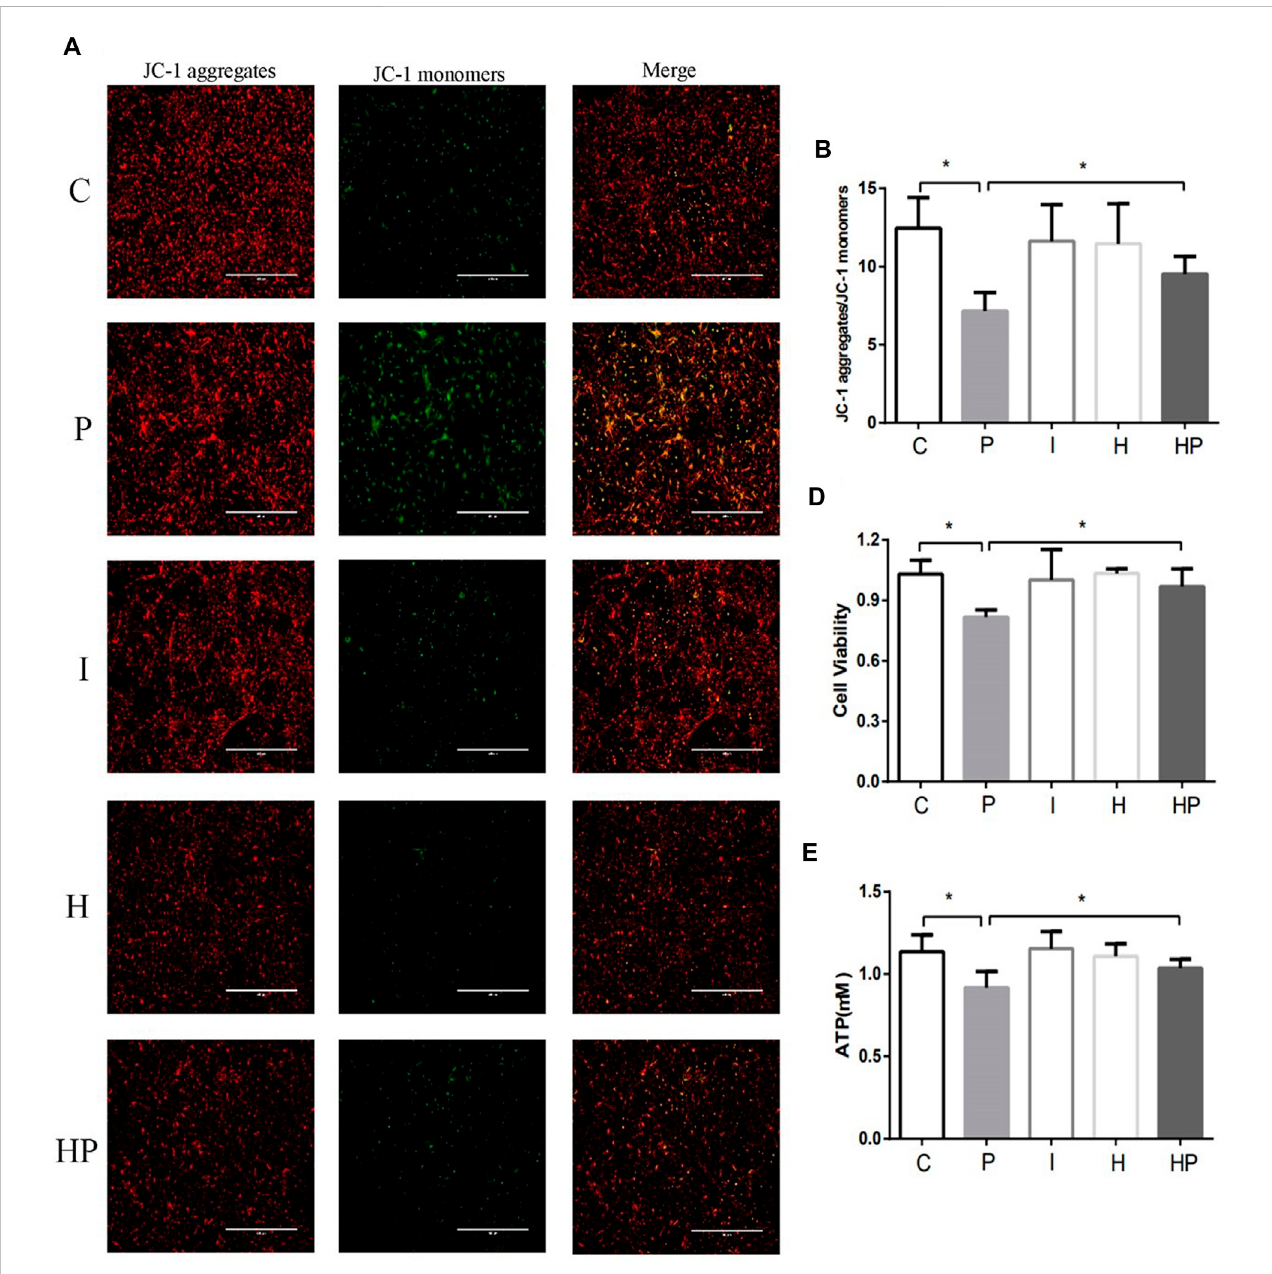
FIGURE 2 Changesinmitochondrial membranepotential, neuronalviabilityandATPinprimaryhippocampal neuronsexposedtopropofol withorwithouthypoxic preconditioning. (A,B) Fluorescence images of JC-1 aggregates and JC-1 monomers indicating the mitochondrial membrane potential in each group (one- way ANOVA, * p < 0.05). (D,E) Cell viability and ATP content in each group (one-way ANOVA, * p <